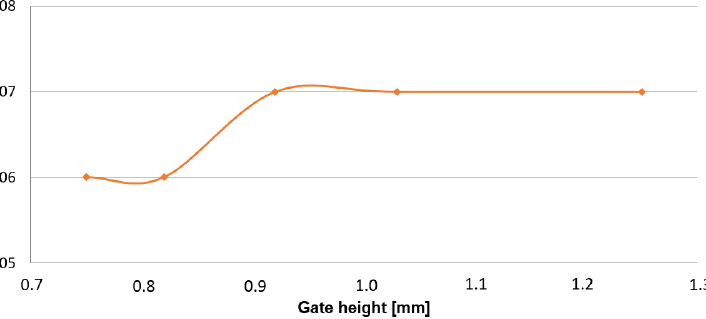
Figure 14. Relationship between the hardness of the diecast part HB and change in the ingate height. Table 9. Values of the surface hardness of the die-cast part “HB” in relation to change of the ingate height. Sample No. Gate Height (mm) Gate Weight (mm)